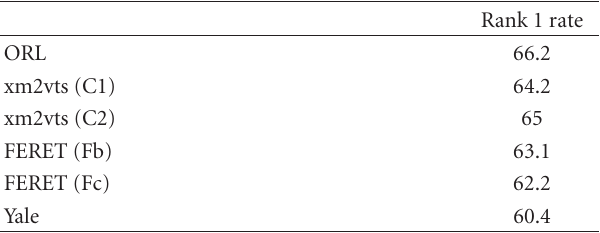
Table 4: The results of 4-component size 15 × 15 for the new